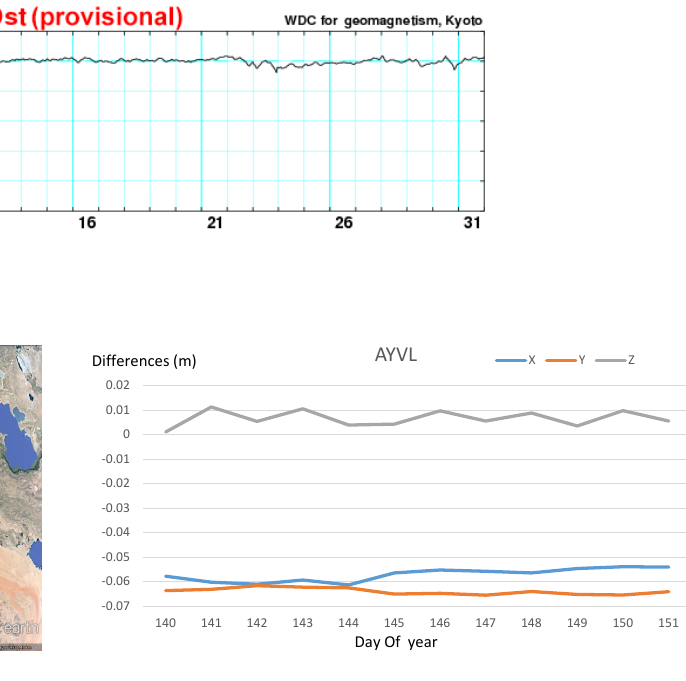
Figure 9. CORS-TR and IGS station distribution. Figure 10. AYVL station coordinate